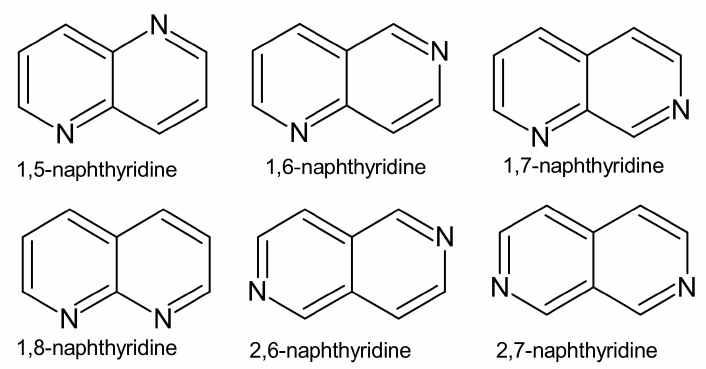
Figure 1. Isomeric forms of naphthyridines.